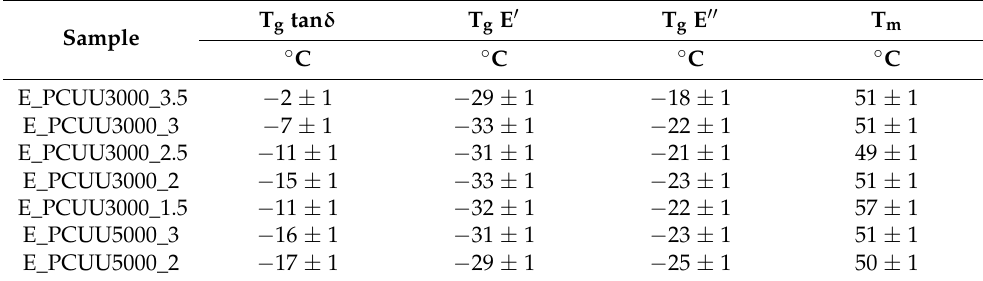
Table 4. T g and melting point based on DMTA.